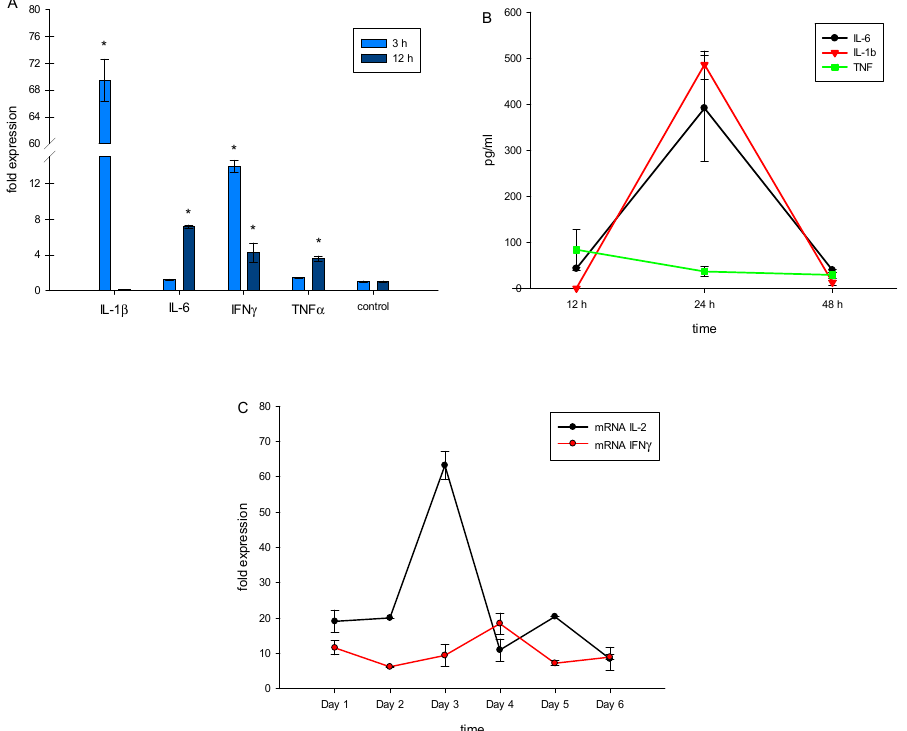
Figure 3. N3 peptide triggers mRNA expression of proinflammatory cytokines TNF α , IL-1 β , IL-6 and IFN γ in PBMCs after 3 and 12 h of incubation ( A ). Secretion of proinflammatory cytokines by PBMCs after 12, 24 and 48 h of incubation with N3 measured using ELISA ( B ). mRNA expression of IL-2 and IFN γ , quantified using RT-PCR each day after N3 peptide treatment ( C ). All values were normalized to control (before any treatment). Levels of mRNA were measured by RT-PCR; levels of RPLP/GADPH were used as reference (one-way ANOVA, p -value * < 0.05 vs. control).